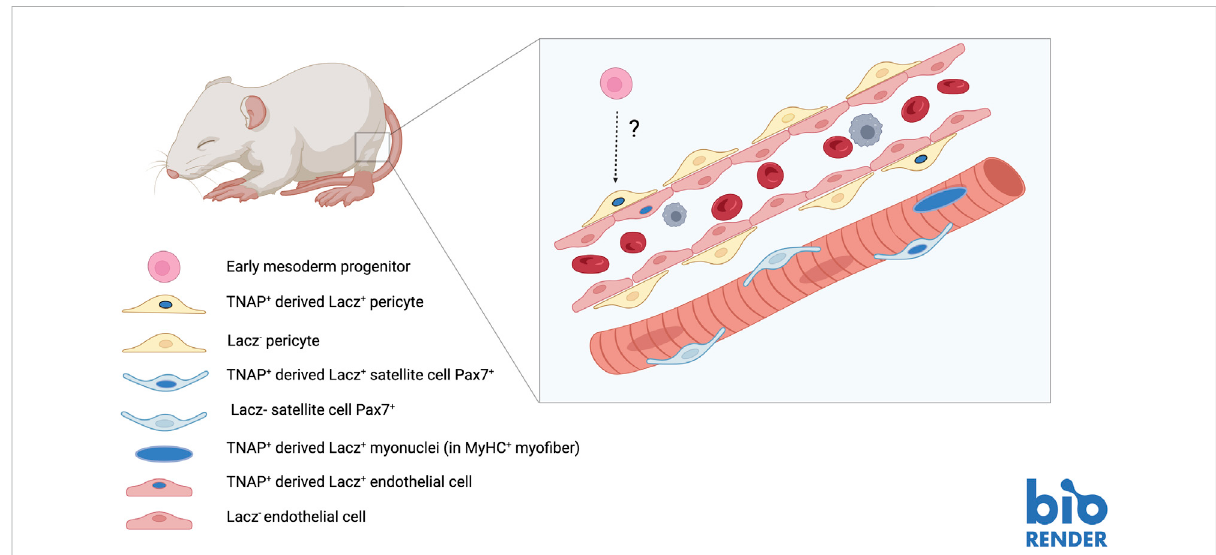
FIGURE 3 Contribution of TNAP + pericyte (MABs) to developing foetal muscle and satellite